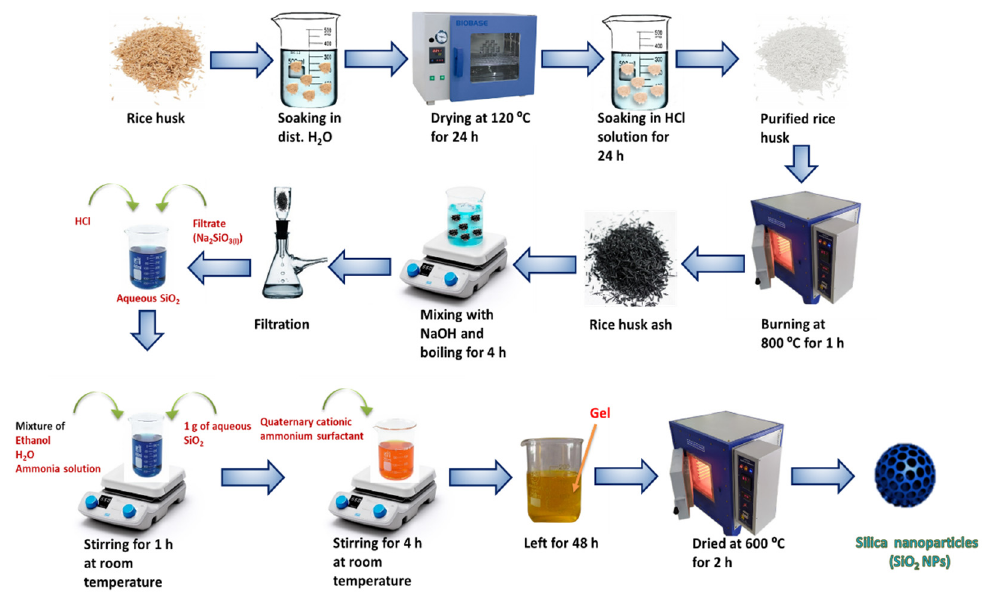
Figure 2. Schematic illustration for preparation of the silica nanoparticles from rice husk ash by sol–gel process.